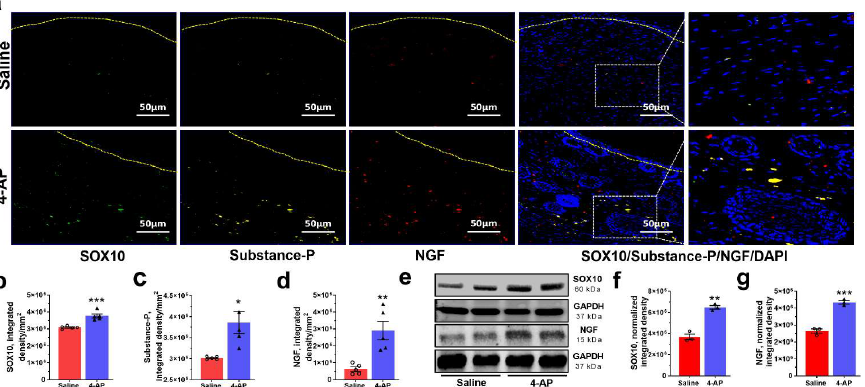
Figure 6. 4-AP enhanced expression of transcription factors, neurotrophic factors, and neuropeptides associated with reinnervation. ( a ) Representative image of triple co-immunostaining of wound skin for the transcription factor SOX10 (green), neuropeptide substance-P (SP—yellow), nerve growth factor (NGF—red), and nuclear stain DAPI (blue) and dashed line denotes epidermal/dermal border. Scale bars = 50 μm. ( b – d ) Quantification of SOX10, substance-P, and NGF expressing cells in healed wounds. Data represents 20 images from 5 different mouse wounds and are shown as mean ± SEM, n = 5 animals per group, statistical significance indicated by asterisks (O = saline mouse data points, ∆ = 4-AP treated mouse data points, * = p between 0.01 and 0.05, ** = p between 0.01 and 0.001, and *** = p between 0.001 and 0.0002 vs. saline). ( e ) Representative image of Western blot of SOX10, NGF, and GAPDH. ( f , g ) Normalized integrated densities for SOX10 and NGF immunoblot. Mean ± SEM, n = 3 animals per group, statistical significance indicated by asterisks (O = saline mouse data points, ∆ = 4-AP treated mouse data points, ** = p between 0.01 and 0.001, and *** = p between 0.001 and 0.0002 vs. saline).